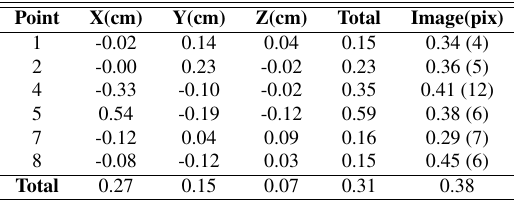
Table 7. GCPs RMSE - Flight 4 - 4/1/2020 12:40PM